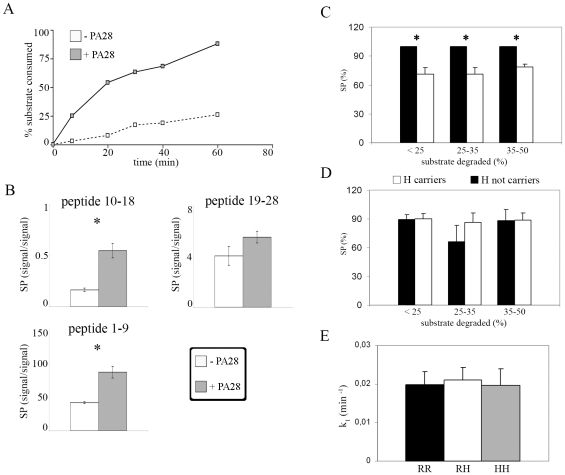
20S immunoproteasomes (+ PA28-αβ) carrying LMP2 60H allele have a lower SP of the MBP111–119 epitope.(A) Chart shows the time-dependent kinetics of MBP102–129 degradation increased in presence of PA28-αβ. (B) Specific production (SP) [expressed as: (peptide signal/consumed substrate signal)*1000] of the MBP111–119 epitope (peptide 10–18 of MBP102–129) and of the two flanking peptides 1–9 and 19–28 in absence or presence of PA28-αβ. The values are the average of the SPs measured at different time points. (C) In presence of PA28-αβ, H-carrier 20S immunoproteasomes have a significant lower epitope SP in all three selected ranges of substrate consumption. No significant difference emerged, on the contrary, in absence of PA28-αβ (D). (E) The similar rate constant K1 of MBP102–129 digestion by 20S immunoproteasomes (in presence of PA28-αβ) carrying the three LMP2 codon 60 variants. All values are given as mean+S.E.M. Statistical significance (p<0.05) is marked with *.